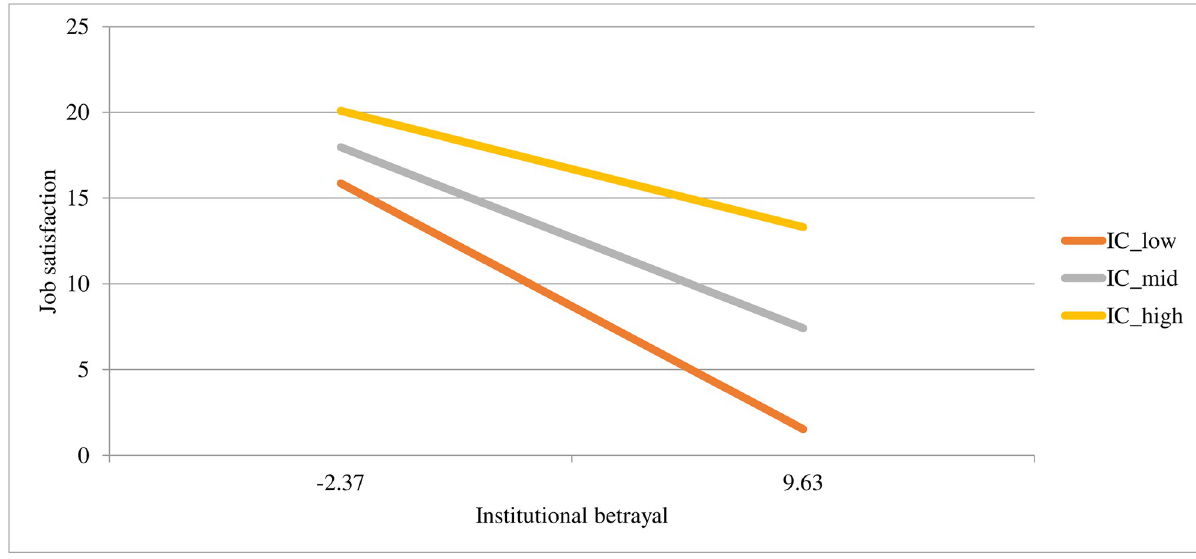
Fig 1. Associations between different levels of institutional courage (at -1SD, the mean, and +1SD) with job satisfaction at different levels of institutional betrayal (at -1SD and +1SD).